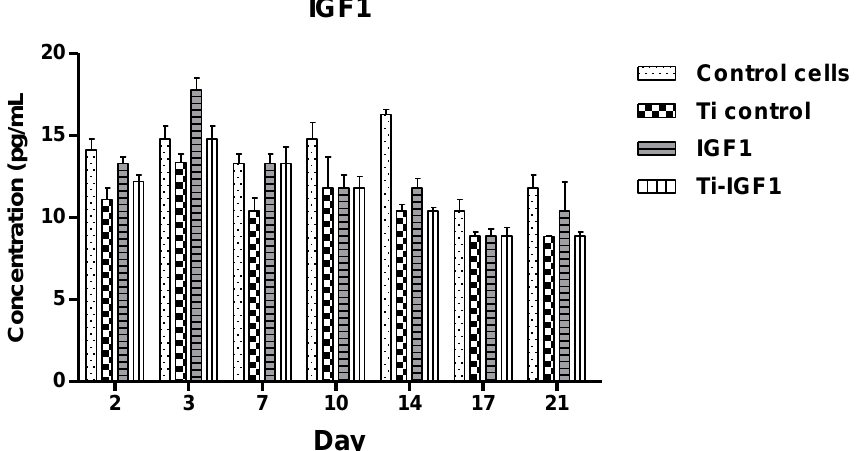
Figure 7. IGF1 concentrations at different time intervals in the culture medium samples from the wells with and without titanium implants. Legend: Control cells: cells seeded in wells containing only culture medium; Ti Control: uncoated titanium implants; Ti-IGF1: titanium implants coated with chitosan film containing microcapsules loaded with IGF1; IGF1: culture medium with added IGF1, without titanium implants.